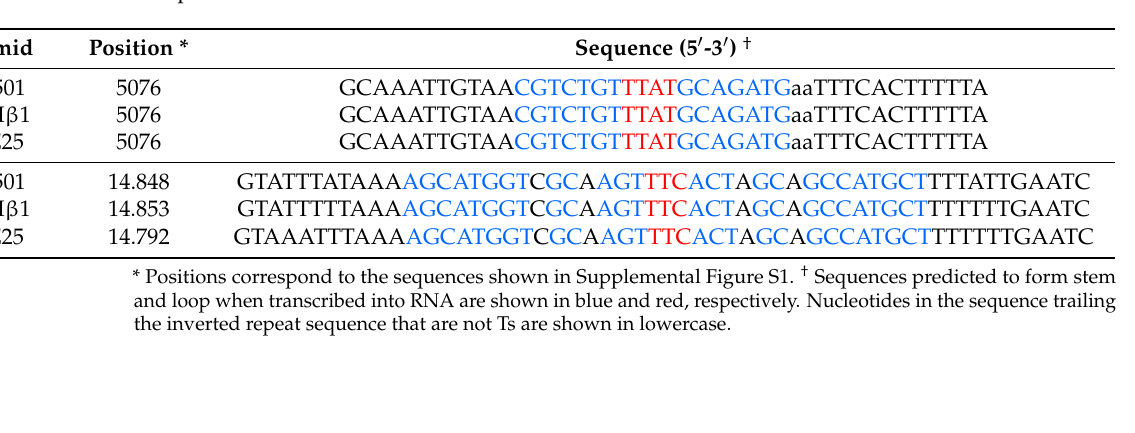
Table 2. Putative terminators detected in the conjugation operons of Inc18 plasmids pIP501, pAM β 1 and